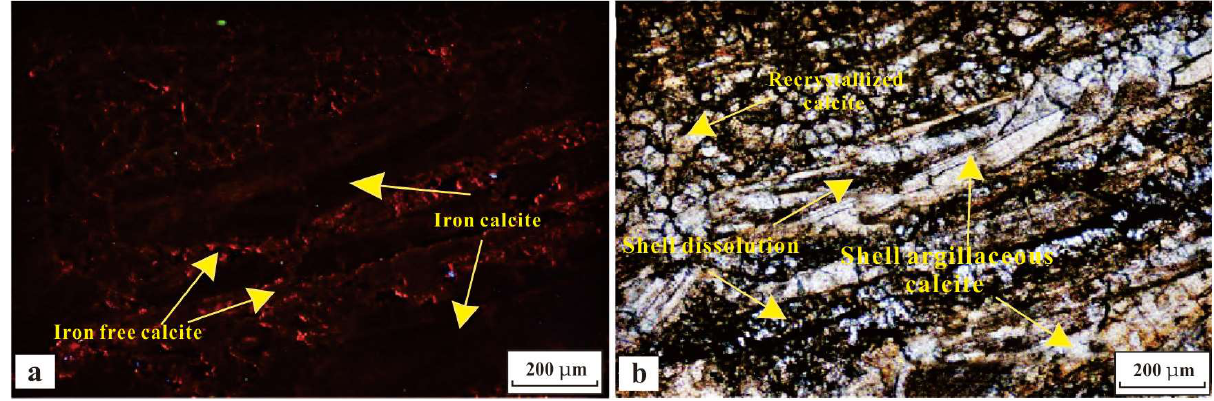
Figure 9. Calcite cement in shell [35]. ( a ) Iron-free calcite cement. ( b ) Dissolution and recrystallization of calcite.